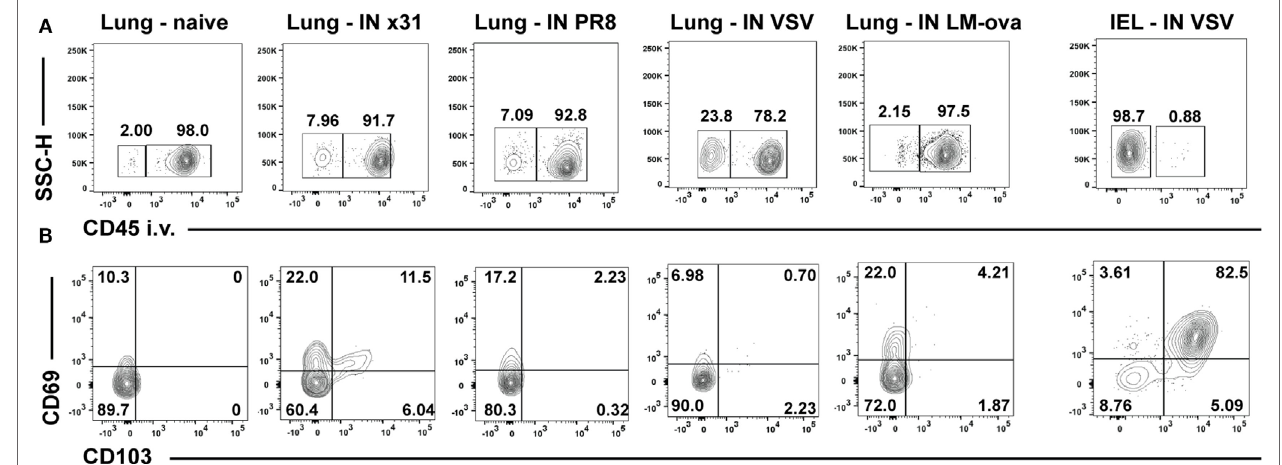
FiGUre 1 | Lung T RM cells express low levels of CD69 and CD103 after respiratory infection with various pathogens. Age- and sex-matched C57/BL6 mice were infected intranasally with a 50- μ l inoculum of PBS alone (naïve) or containing sublethal doses of either influenza (10 3 pfu of strain HKx31 and 10 pfu of PR8), VSV (10 4 pfu, Indiana strain), or Listeria monocytogenes expressing the recombinant ovalbumin (ova) (LM-ova) (10 4 cfu). One group of mice was additionally intravenously (i.v.) infected with 10 4 pfu VSV. Animals were sacrificed 35 days later and T RM assessed by intravascular staining. Briefly, mice were injected i.v. with 3 μ g FITC labeled α CD45 antibody 3 min before sacrifice, lungs or small intestine were harvested, and lymphocytes isolated as previously described (22). (a) Representative i.v. staining of lymphocytes isolated from the lungs or intraepithelial lymphocytes (IEL) of naïve mice or following the indicated infections. All samples were first gated on CD8 + CD44 + memory phenotype cells and gates in (a) were set by FMO controls within each experiment. For the influenza and VSV-infected animals, an additional MHC-class I tetramer gate was applied to identify antigen-specific CD8 T cells [as in Ref. (61)]. Numbers in the right box represent the frequency of the gated cells that stained with the i.v. injected antibody ( α CD45-FITC + ) and are in the vasculature (IV + ). (b) Representative CD103 and CD69 staining of IV − [resident cells, left box in (a) ] cells from the various